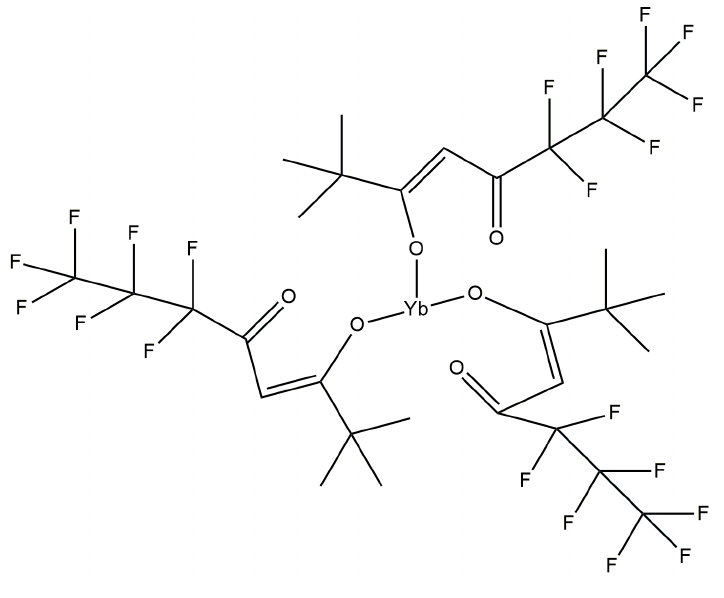
H O F ) 10 10 2 7 3